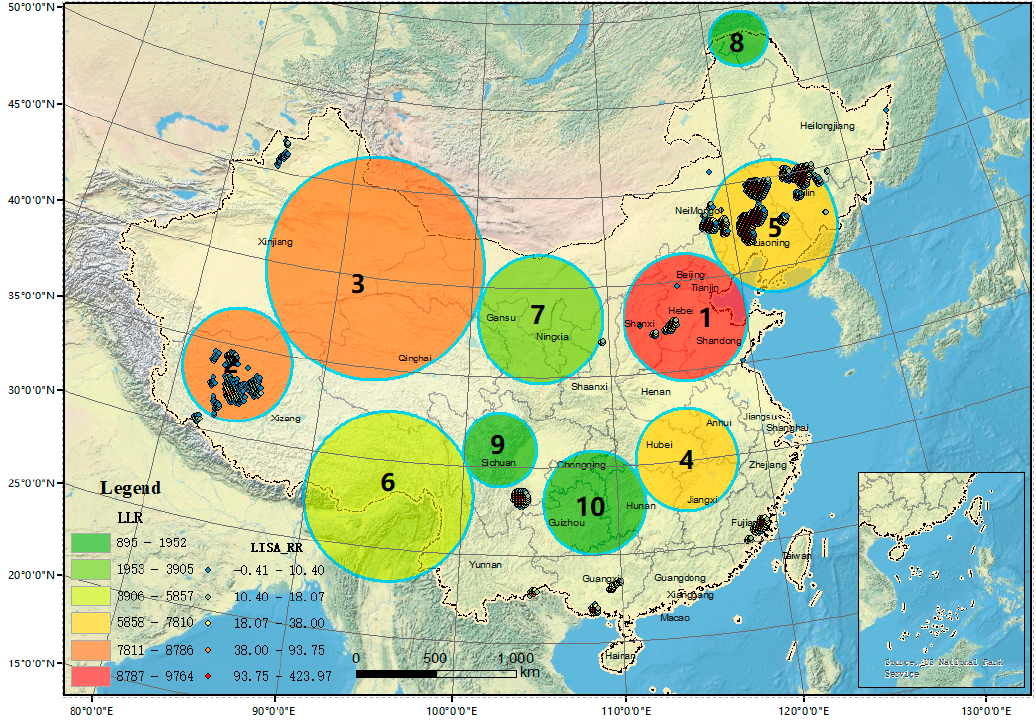
Figure 8. Overlap between the high–high value areas and the clusters of the STSM on 28 July 2016.